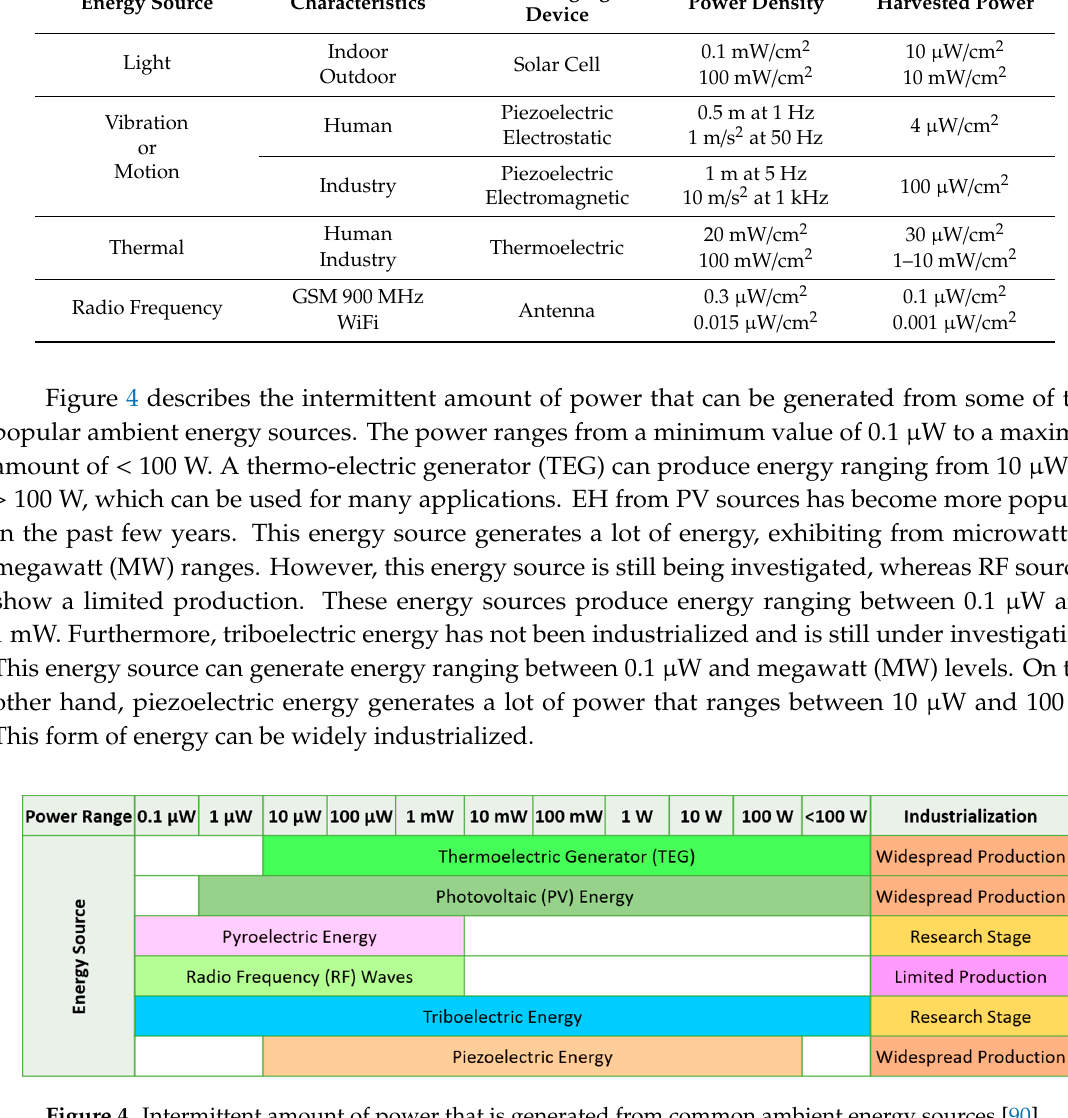
Table 3. IoT applications and the different EH systems (EHSs) [91].